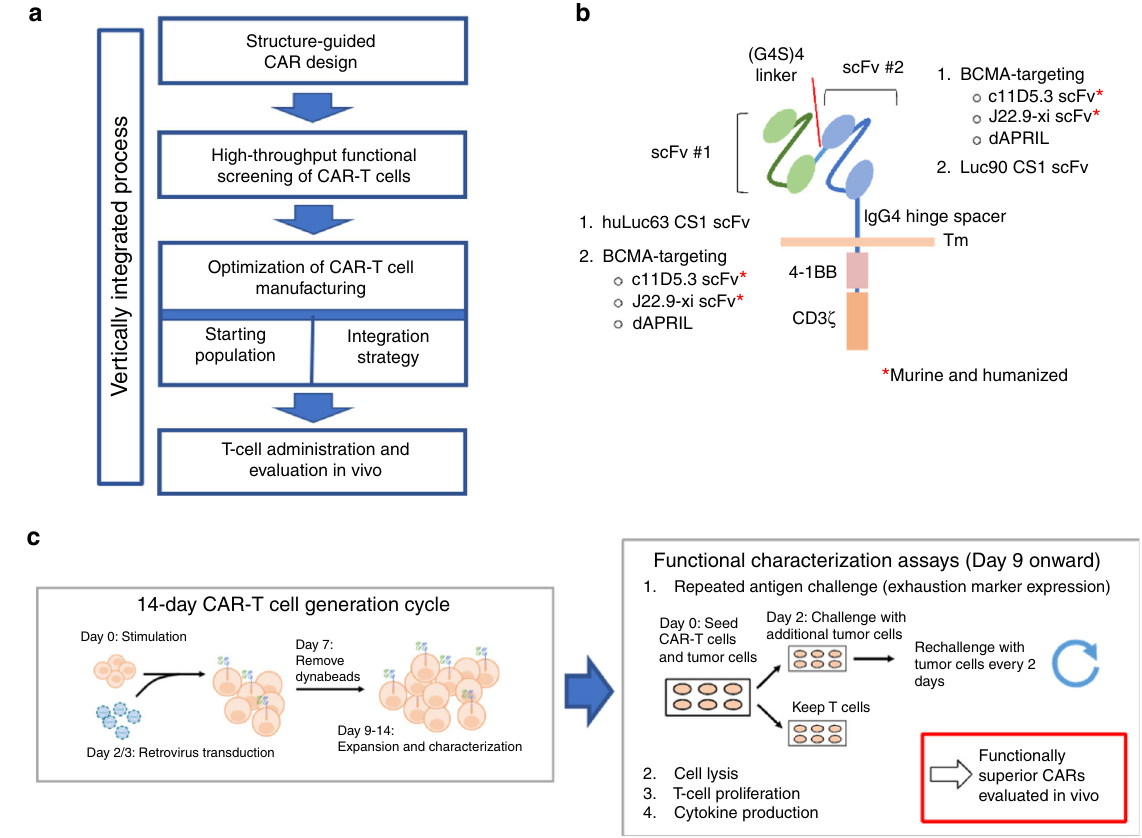
Fig. 1 High-throughput generation and screening of BCMA/CS1 OR-gate CARs. a A vertically integrated optimization process for CAR-T cell therapy development. b Schematic of a single-chain bispeci fi c (OR-gate) CAR, which contains two ligand-binding domains connected in tandem. A panel of CAR variants was constructed from two CS1-binding scFvs and three BCMA-speci fi c binding domains. Both murine and humanized versions of BCMA-binding scFvs (c11D5.3 and J22.9-xi) were evaluated. The CS1-binding huLuc63 and Luc90 scFvs were fi xed at the membrane-distal and membrane-proximal positions, respectively, based on binding-epitope analysis. c Methodology for producing and screening bispeci fi c CARs. CAR-T cells were generated in a 14- day cycle. Starting on day 9 post-stimulation, CAR-T cells were characterized for antitumor function in various assays, which could last up to 2